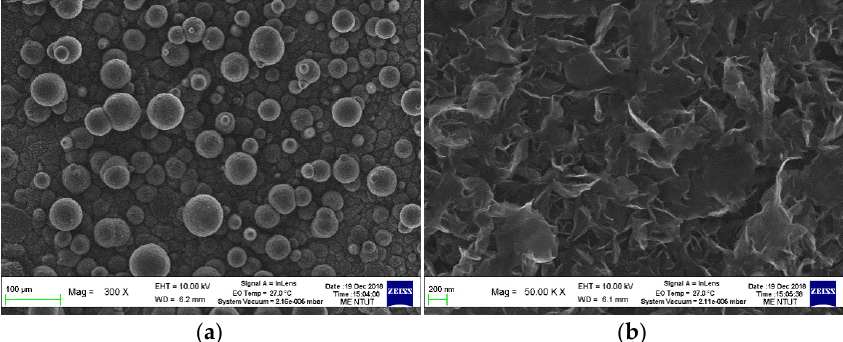
Figure 13. SEM image with ( a ) 300 X and ( b ) 50,000 X of the diamond film grown on the graphite substrate with working gas containing 32% methane.